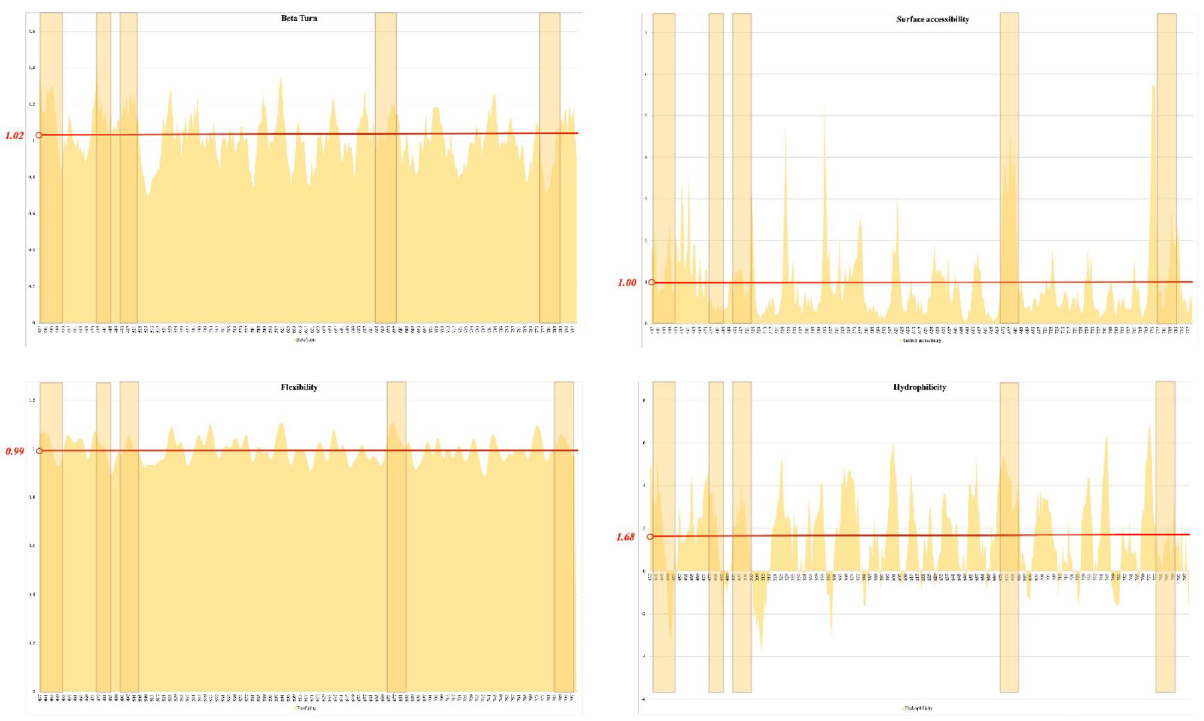
Figure 1. Physicochemical properties of the spike glycoprotein region (S 437–806 ). Four physicochemical properties of the selected region of spike glycoprotein in favor of B-cell epitope propensity are presented by histograms. The selected regions in each histogram are shown by light brown transplant boxes; each graph is labeled by the related property. X-axes are the amino acid number and Y-axes are the score of the